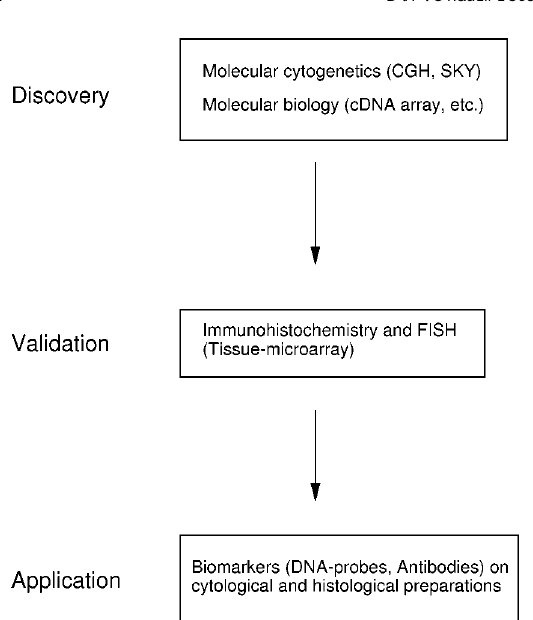
Fig. 1. Flow chart: from gene discovery to clinical application. Such a chromosomal marker has the potential to be- come useful as a predictor for the progressive poten- tial of premalignant lesions. Unlike cervical carcino- genesis, a higher number of recurring chromosomal changes can be detected in tumours of, e.g., the breast, colon, ovary, and pancreas. CGH studies, however, in- dicate that the utilization of up to 4 different DNA probes specific for recurrently involved chromosome arms will be sufficient to detect almost all